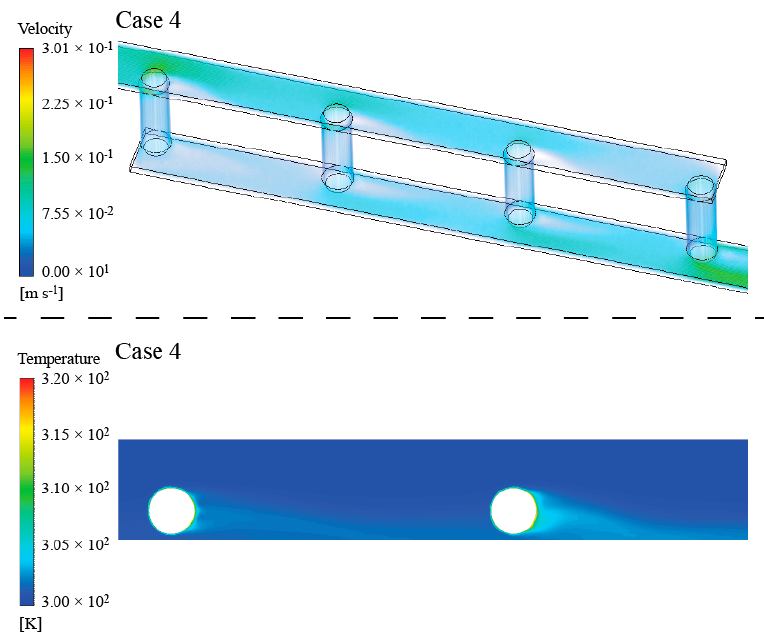
Figure 10. Partial display of velocity flow rates ( top ) and temperature map in the distribution channel near the second and third heat pipe heads ( bottom ).